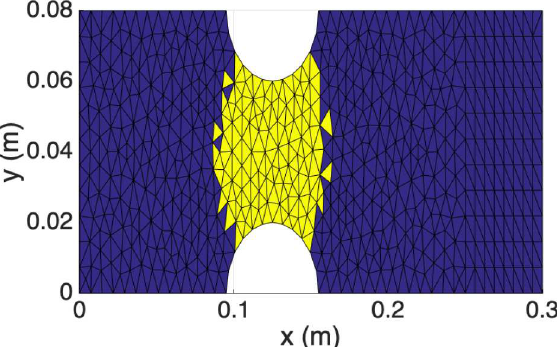
Fig. 21. Plastic localization at time t = 3 × 10 − 3 s (elements colored in yellow are experiencing plastic deformation).